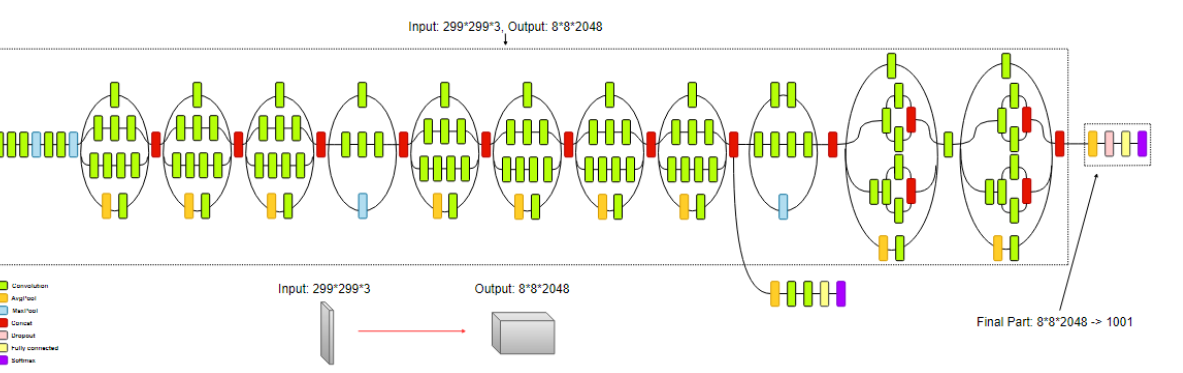
Figure 12. InceptionV3 architecture.